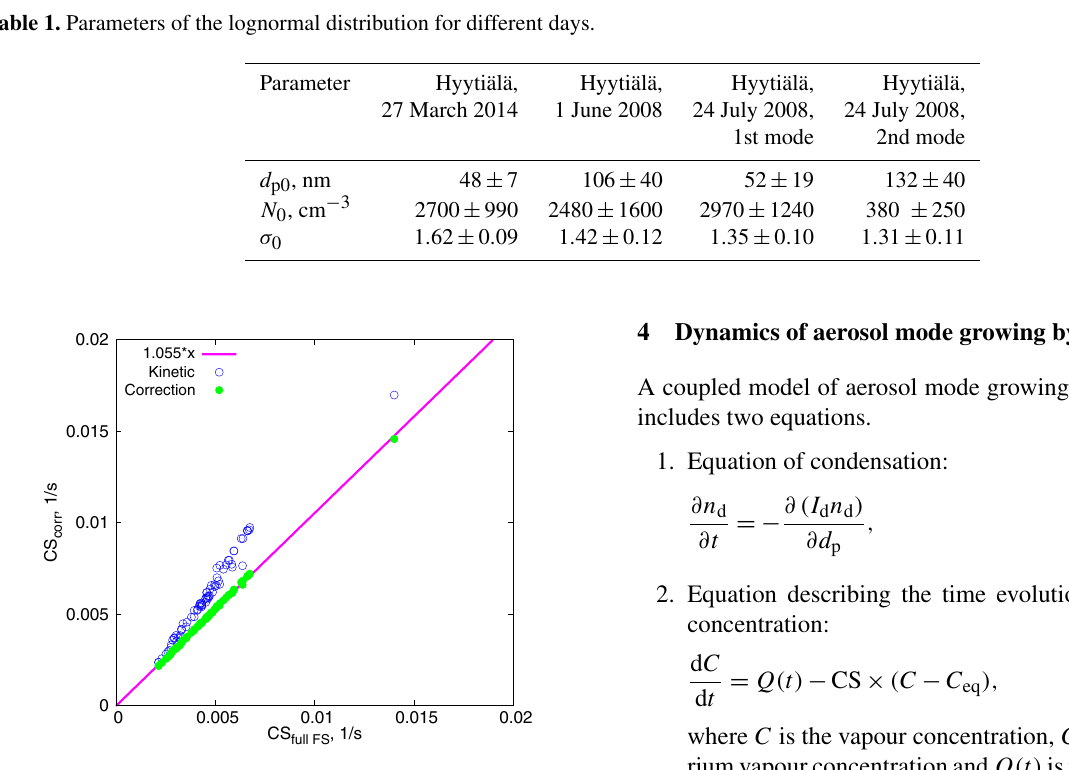
Figure 6. CSs calculated using two approximations vs. CSs calcu- lated using the full FS formula. The magenta line corresponds to CS corr = CS fullFS × 1 .